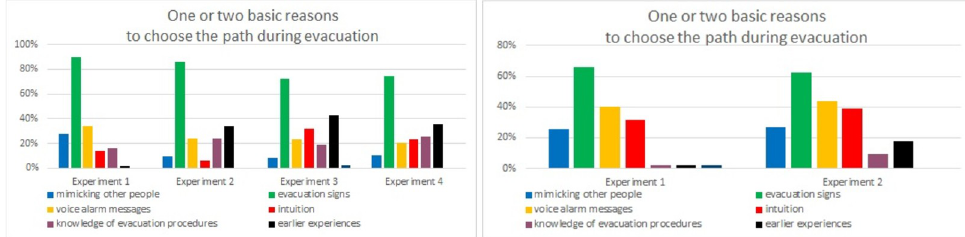
Fig 11. Reasons to choose a specific evacuation path–question 2. (Results from Laliki experiment are on the left; results from Gda ń sk are on the right).